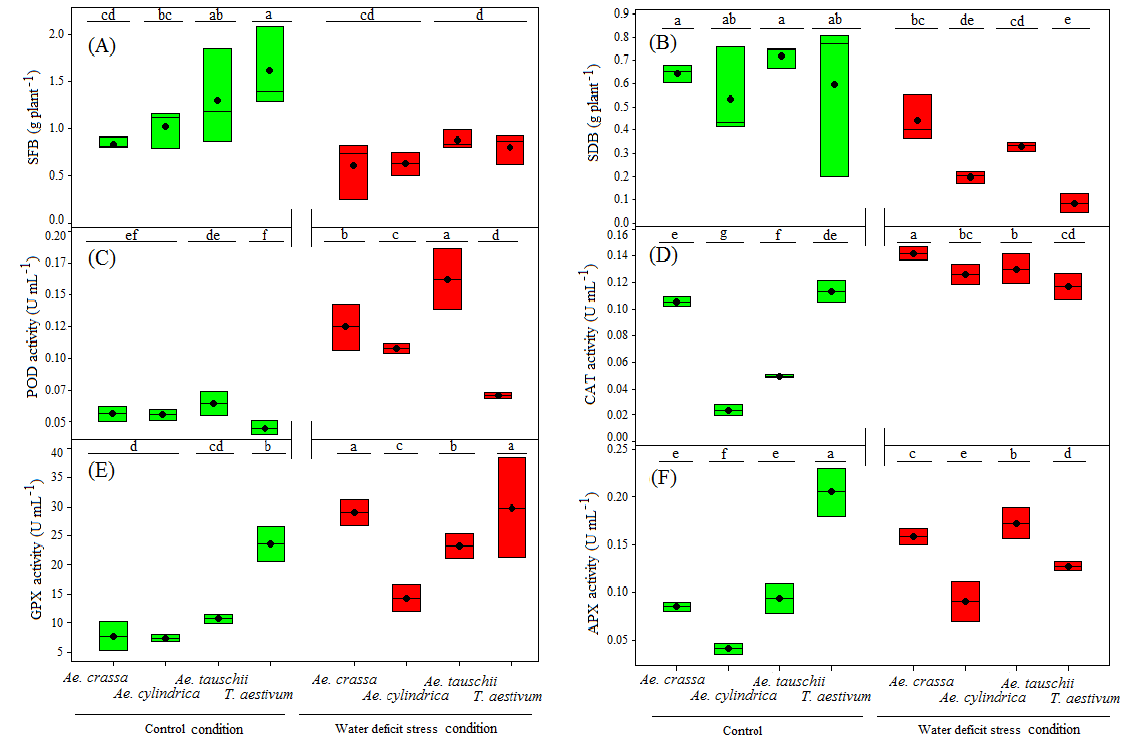
Figure 1. Box plots of investigated accessions for ( A ) SFB (shoot fresh biomass), ( B ) SDB (shoot dry biomass), ( C ) POD (peroxidase activity), ( D ) CAT (catalase activity), ( E ) GPX (guaiacol peroxidase activity), and ( F ) APX (ascorbate peroxidase activity) under the control and water deficit stress conditions. Different letters on each box indicate a significant difference at p ≤ 0.01. In each dot box, the horizontal bar within the box and the internal boxes indicate the mean, median, and the first and third quartiles, respectively.